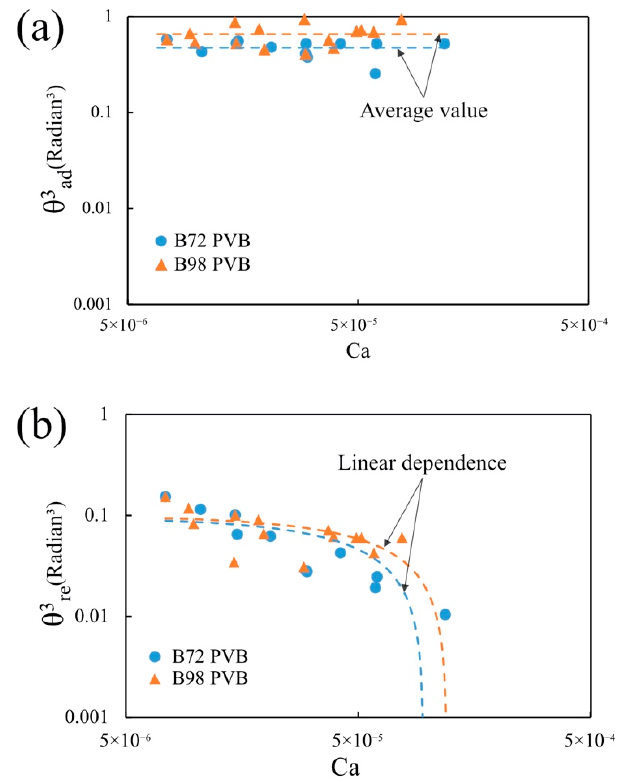
Figure 8. The capillary number dependence in the logarithmic scale of ( a ) the advancing dynamic contact angle θ a and ( b ) the receding dynamic contact angle θ r . To guide the reader, the dashed curves corresponding to the linear dependences are shown.